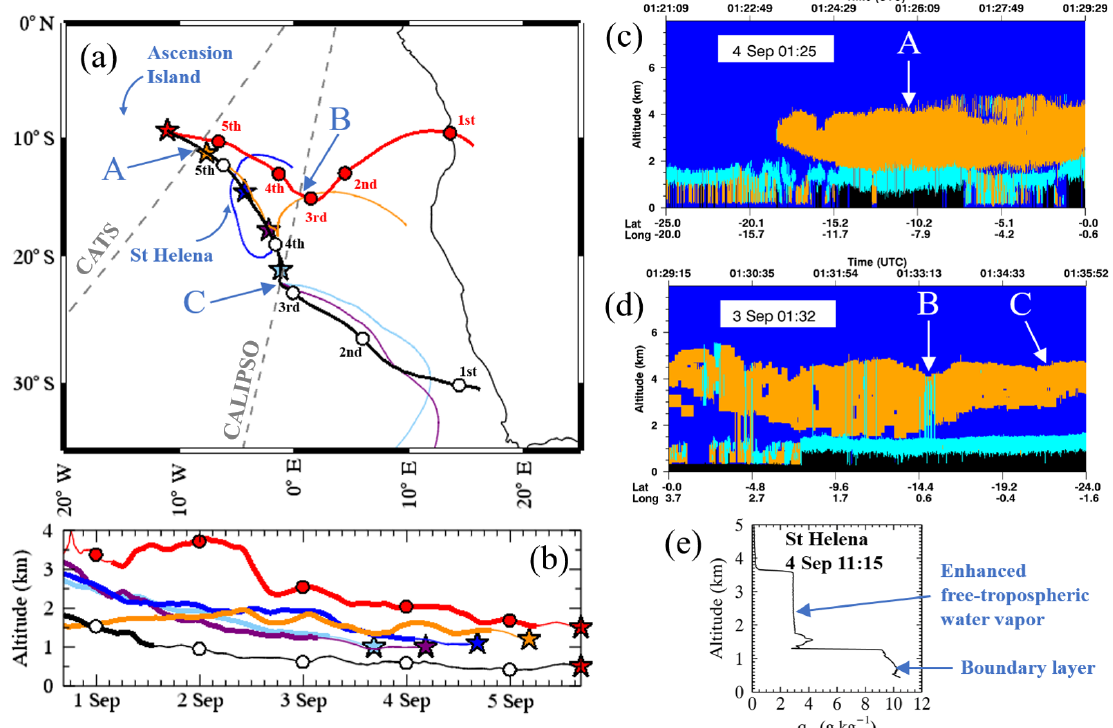
Figure 4. Examination of the air mass history of the POC. The black and red tracks in panel (a) are back trajectories initialised from the time and position of the aircraft observations in the POC (red star). The black trajectory was started at an altitude within the surface mixed layer (0.5km) and the red trajectory beneath the boundary layer inversion (1.5km). Additional back trajectories initialised at an altitude beneath the inversion at 12-hourly positions along the black 0.5km trajectory are also shown. The orange, dark blue, purple and light blue stars are the trajectory start points. Panel (b) shows the altitude above mean sea level of these trajectories as a function of time. The thick lines along each trajectory are where the model relative humidity is < 30%, which is indicative of when the air mass was in the free troposphere. Panels (c, d) show the lidar feature mask from CATS and CALIPSO, respectively. Aerosol and clouds are shown with orange and cyan colours, respectively. The satellite tracks are overlaid with a dashed line in panel (a) and occasions where the lidar data are in the vicinity of the trajectories are labelled A to C. Panel (e) shows a radiosonde profile of specific humidity from St. Helena, launched at 11:15UTC on 4 September 2017. The date labels in panels (a, b) are valid at 00:00UTC on each